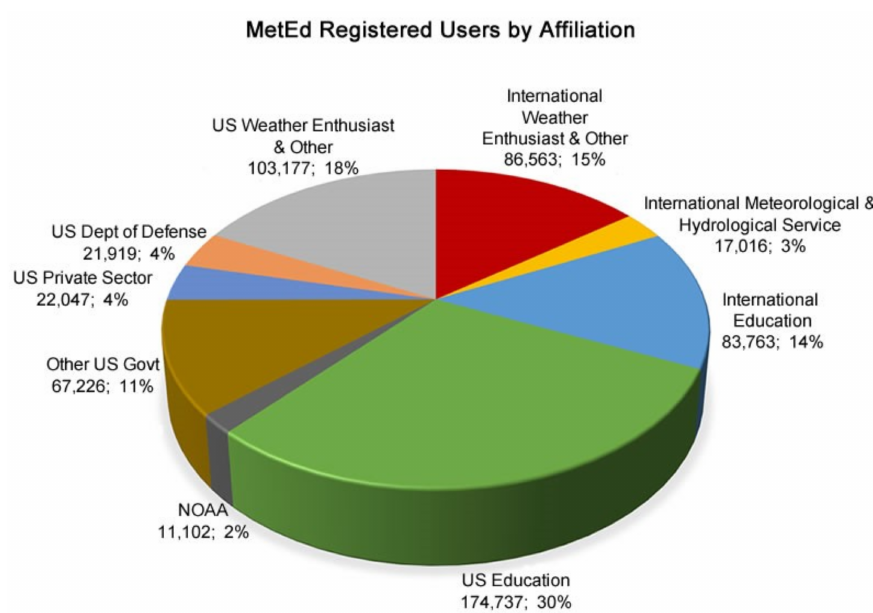
Figure 10. MetEd users can voluntarily report their a ffi liation when registering in the system. A total of 44% of MetEd learners are a ffi liated with universities, both within the US and internationally. Learners identifying as “weather enthusiasts” and “other” also represent a substantial number of users, and government sector forecasters and scientists make up other user groups on